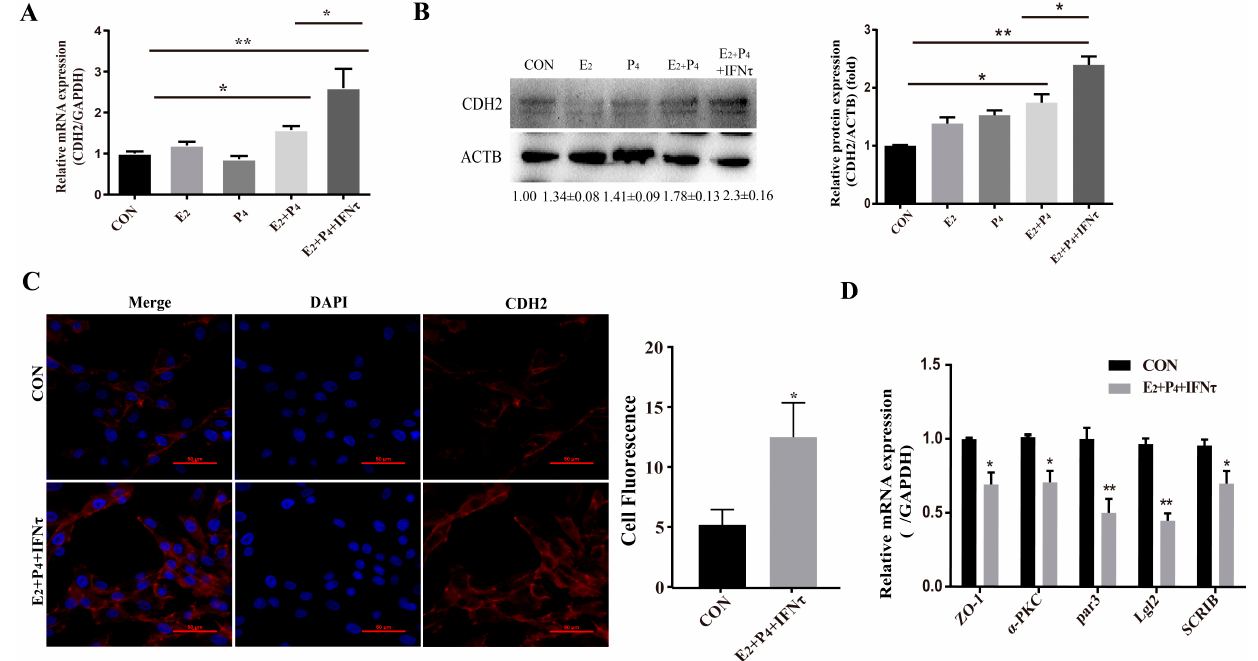
Figure 4. Hormones and/or IFN τ induced the PMT of gEECs. ( A ) mRNA level of CDH2 with E 2 , P 4 , or/and IFN τ treatment; ( B ) Western blot and quantitative analysis results of CDH2 with E 2 , P 4 , or/and IFN τ treatment; ( C ) representative images and analysis of CDH2 expression, scale bar = 50 μ m; ( D ) mRNA levels of polarity-related genes: ZO-1 , α -PKC , Par3 , Lgl2 , and SCRIB . * p < 0.05; ** p <